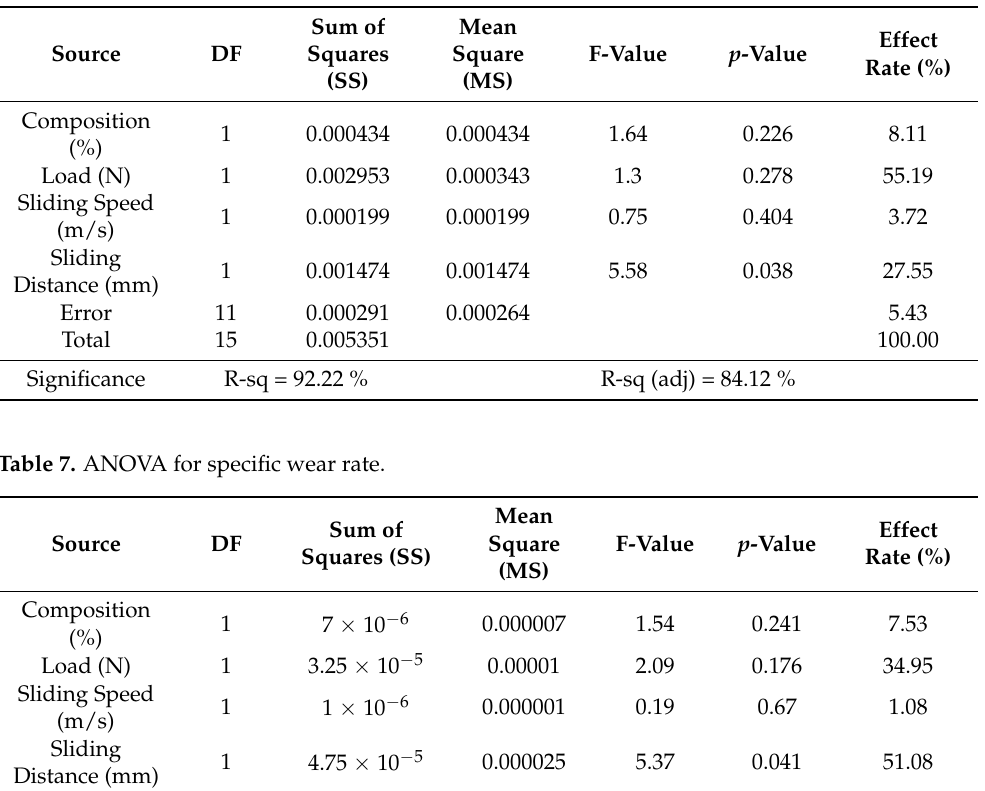
Table 6. ANOVA for Weight Loss.